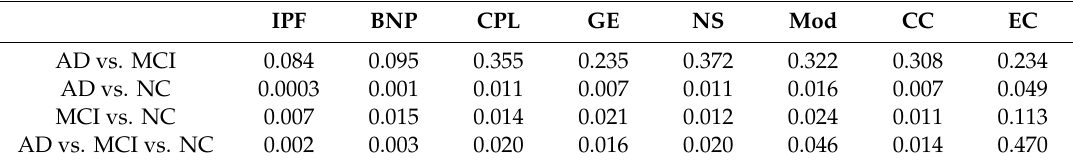
Table 2. Resulting p -values of differences across three groups evaluated by different measures on DK68 parcellation.